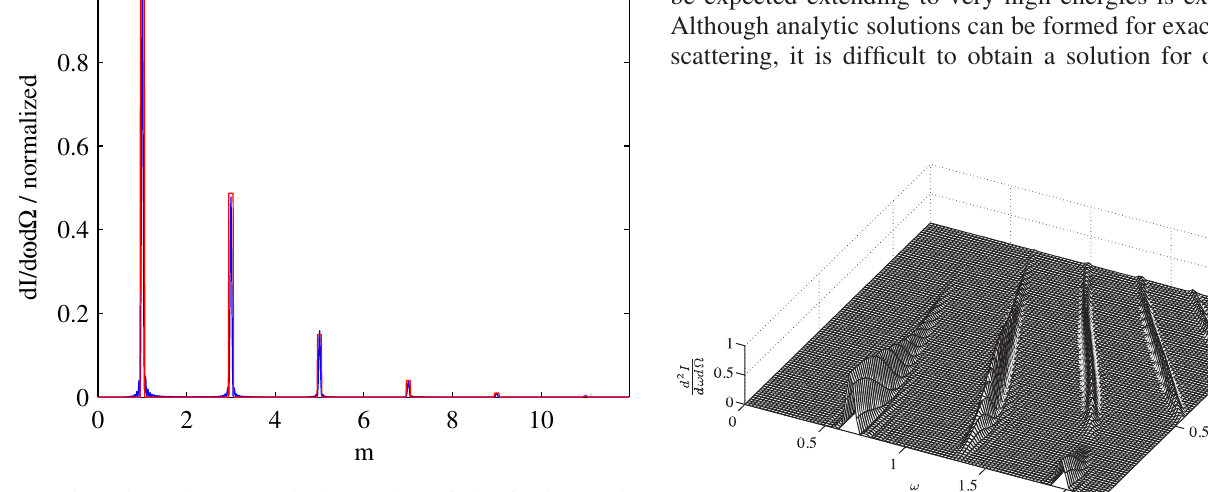
FIG. 5. (Color) The power in harmonics of the fundamental frequency, normalized to the first harmonic, due to nonlinear Thomson backscattering from a 5 MeV electron beam colliding with a linear polarized plane wave with a normalized vector potential of a 0 ¼ 1 . (red) Calculated from the analytic expres- sion of Ref. [27] and represented by vertical bars of (arbitrary) finite width. (blue) Calculated from numerical